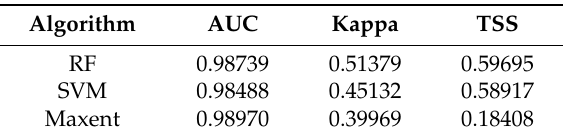
Table 2. Evaluation of prediction using Random Forest (RF), Support Vector Machine (SVM) and Maxent models.